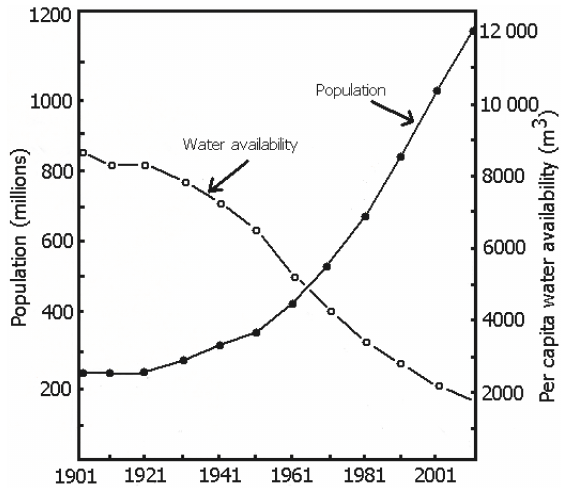
Figure 2. Population and water availability trends